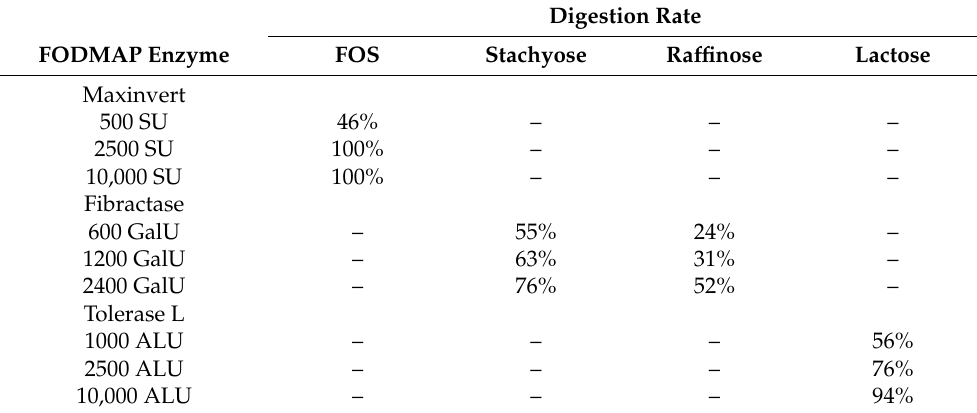
Table 1. FODMAP digestion by individual FODMAP